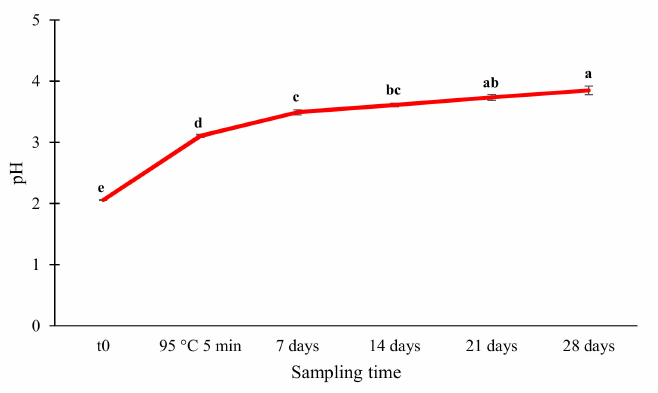
Figure 3. Results of pH measurements into acidified sea fennel preserves. Values are expressed as means ± standard deviation. For each sampling time, values labelled with different letters are significantly different ( p < 0.05) by one-way ANOVA